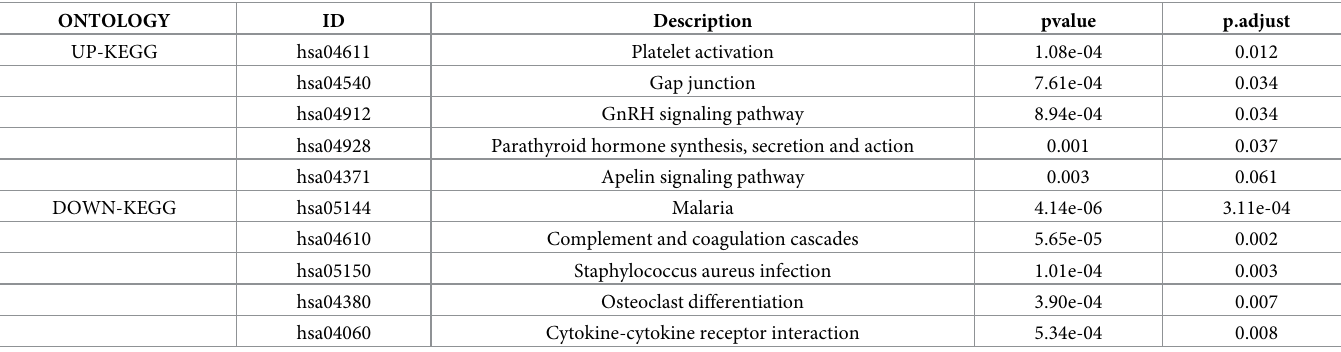
Table 2. KEGG analysis of common up-regulated DEGs and common down-regulated DEGs among COVID-19 and HCC.